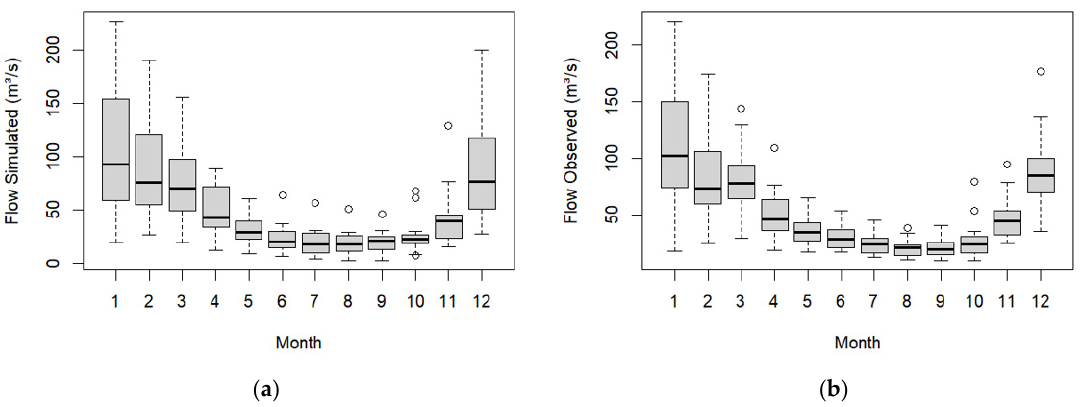
Figure 9. ( a ) Monthly variation simulated and ( b ) monthly variation observation at the Alberto Flores fl uviometric station. fluviometric